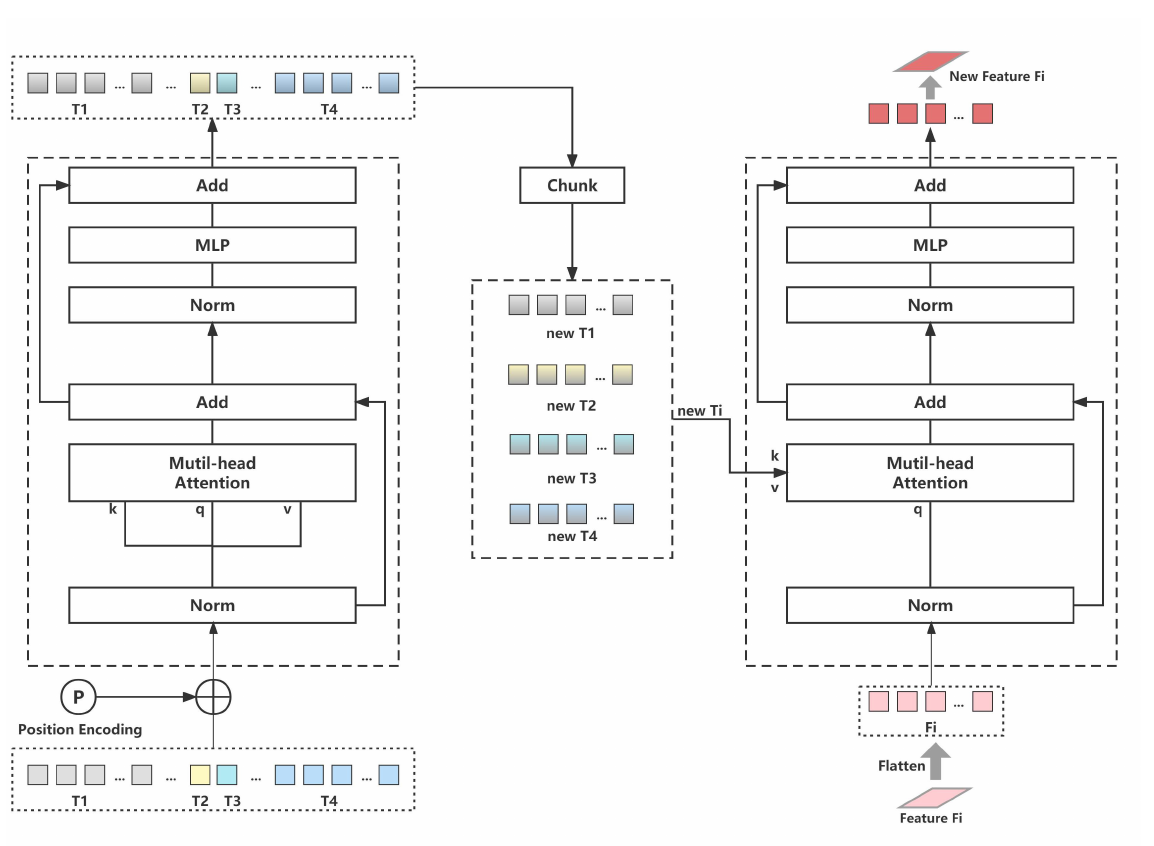
Figure 5. The diagram of the transformer